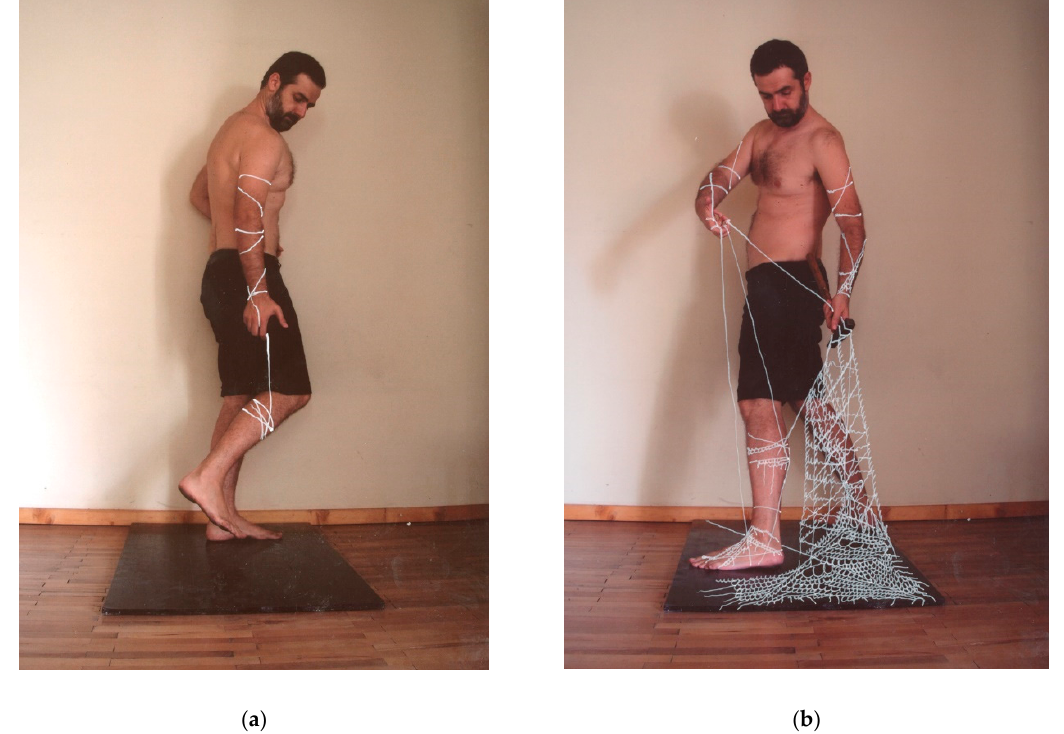
Figure 3. Peter Tzanev, Ectoplastic exercises: ( a ) Ectoplastic drawing, 2007; ( b ) Ectoplastic drawing, 2007; Images created by author.